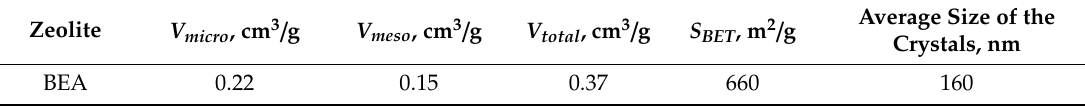
Table 4. Textural characteristics of the BEA zeolite.